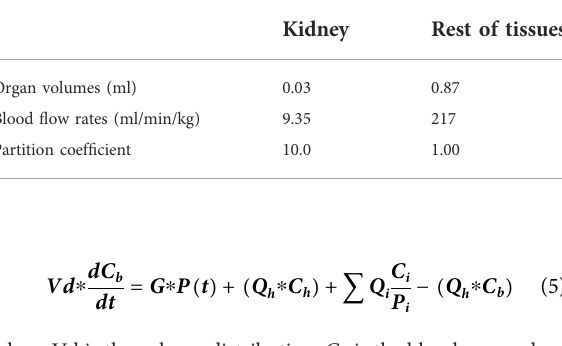
TABLE 1 General physiological parameters values implemented in the gentamicin minimal PBPK